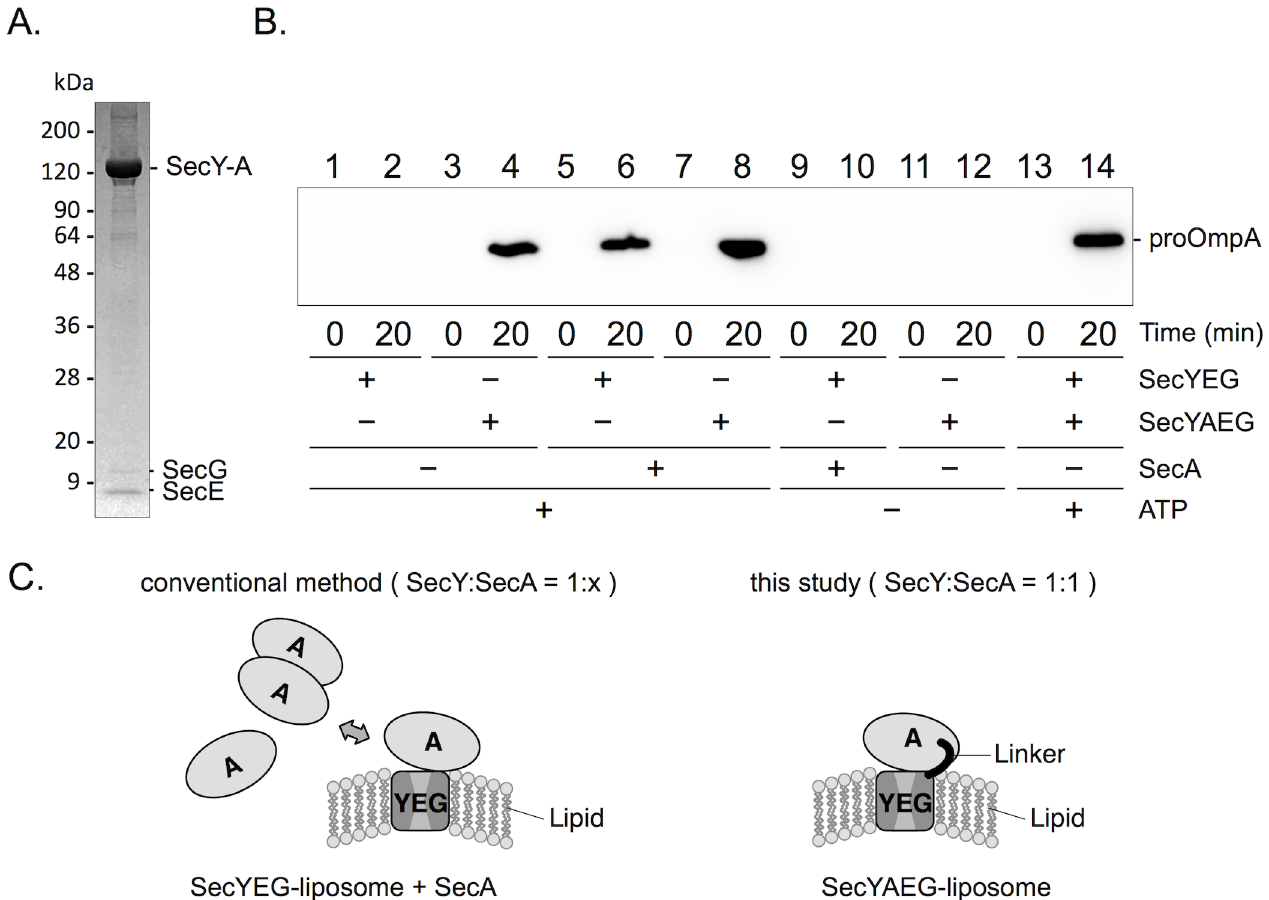
Fig 1. Protein translocation activity of the SecYAEG complex embedded in liposomes. A, Purified SecYAEG complex analyzedby SDS-PAGE and Coomassie BrilliantBlue staining;B, Protein translocation assay using SecYAEG-reconstituted or SecYEG-reconstituted liposomesin the presenceor absenceof SecA ATPase; protease-resistant translocated substrate, proOmpA-His 6 -Myc, was detected by anti-Myc immunoblotting. C, Schematic depictionof the protein translocation systems in vitro .